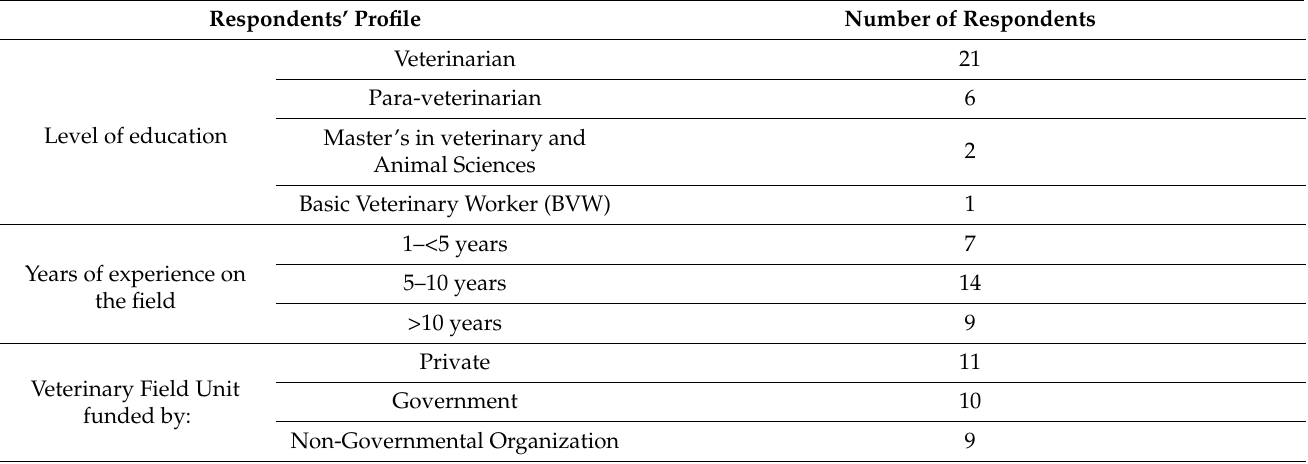
Table 5. The perceptions of the veterinary professionals ( n = 30) about foot and mouth disease (FMD). Respondents’